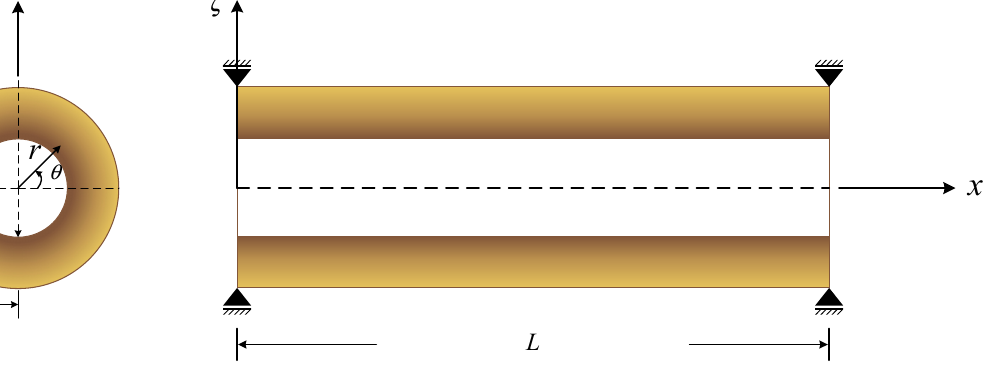
Figure 1. The schematic diagram of a simply-supported FG cylindrical microshell.